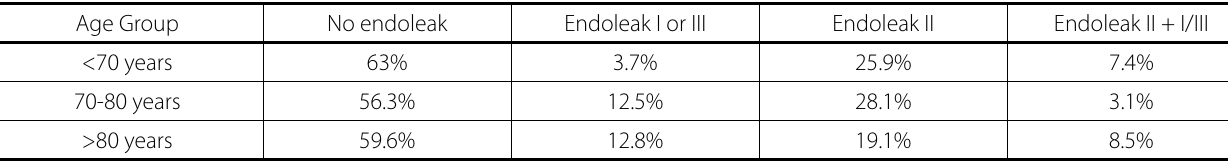
Table 5. Type of endoleak by age group.